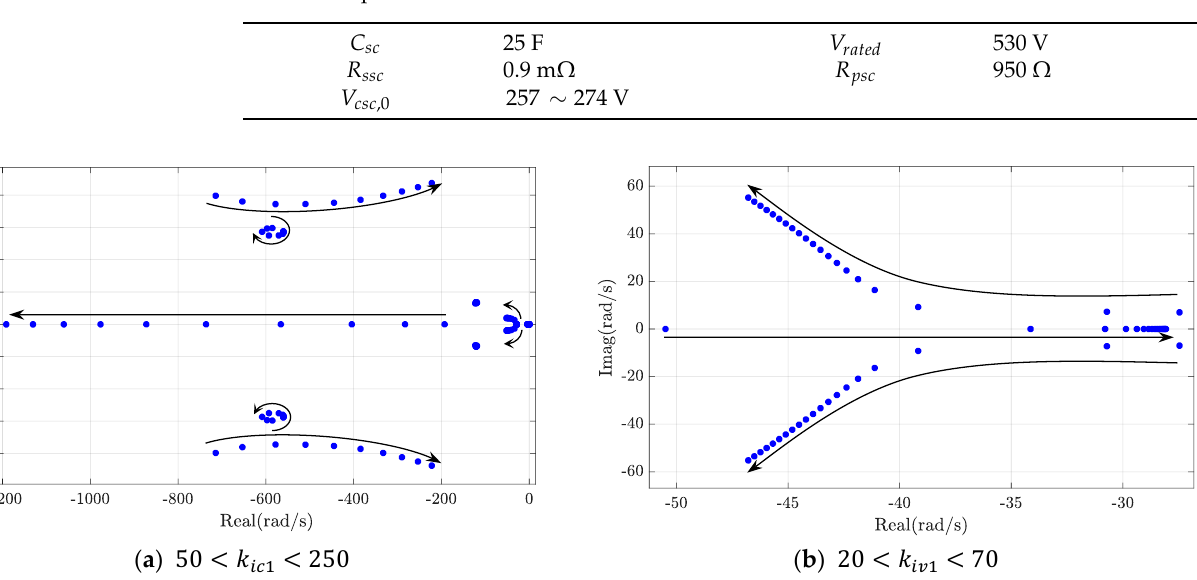
20 < 𝑘𝑘 𝑖𝑖𝑝𝑝1 < 70 Figure 16. Pole map of the PVSC small-signal model for the variation of DC-DC control system parameters: ( a ) variation